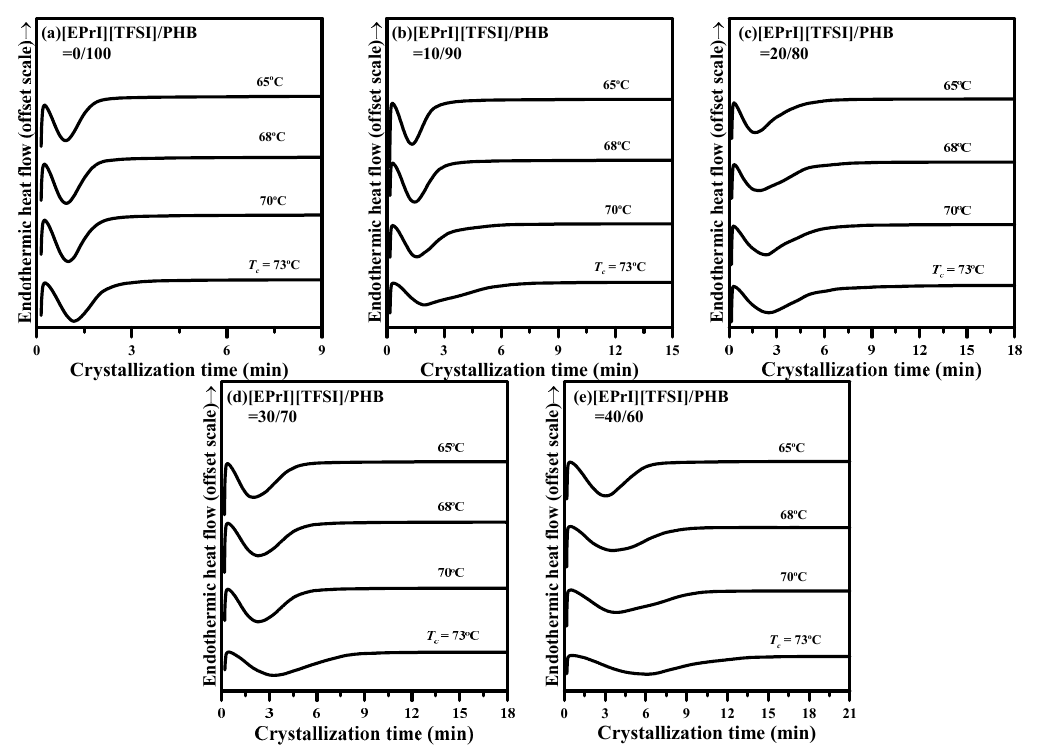
Figure 3. DSC isothermal crystallization thermograms of [EPrI][TFSI]/PHB blends with different compositions: ( a ) 0/100; ( b ) 10/90; ( c ) 20/80; ( d ) 30/70; and ( e ) 40/60.